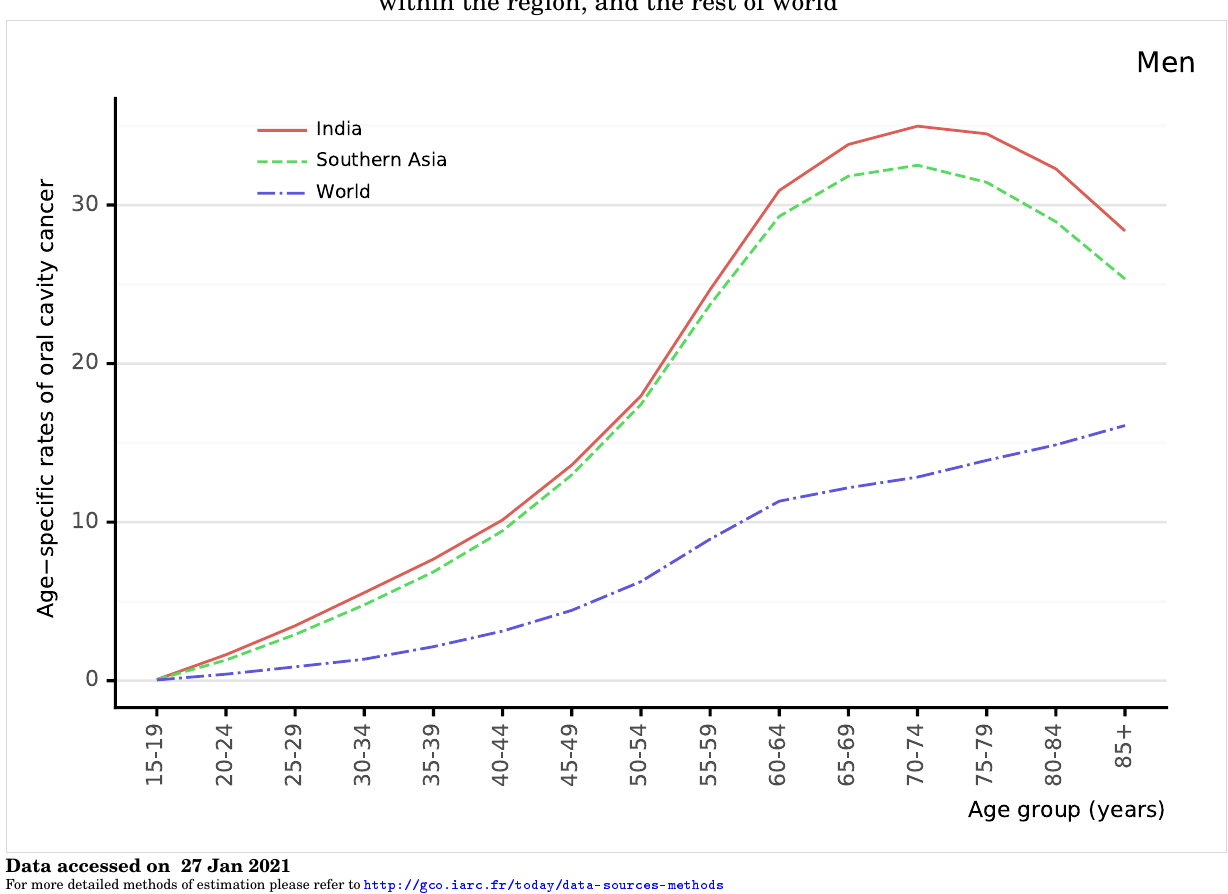
Figure 130: Comparison of age-specific oral cavity cancer mortality rates among men by age in India, within the region, and the rest of